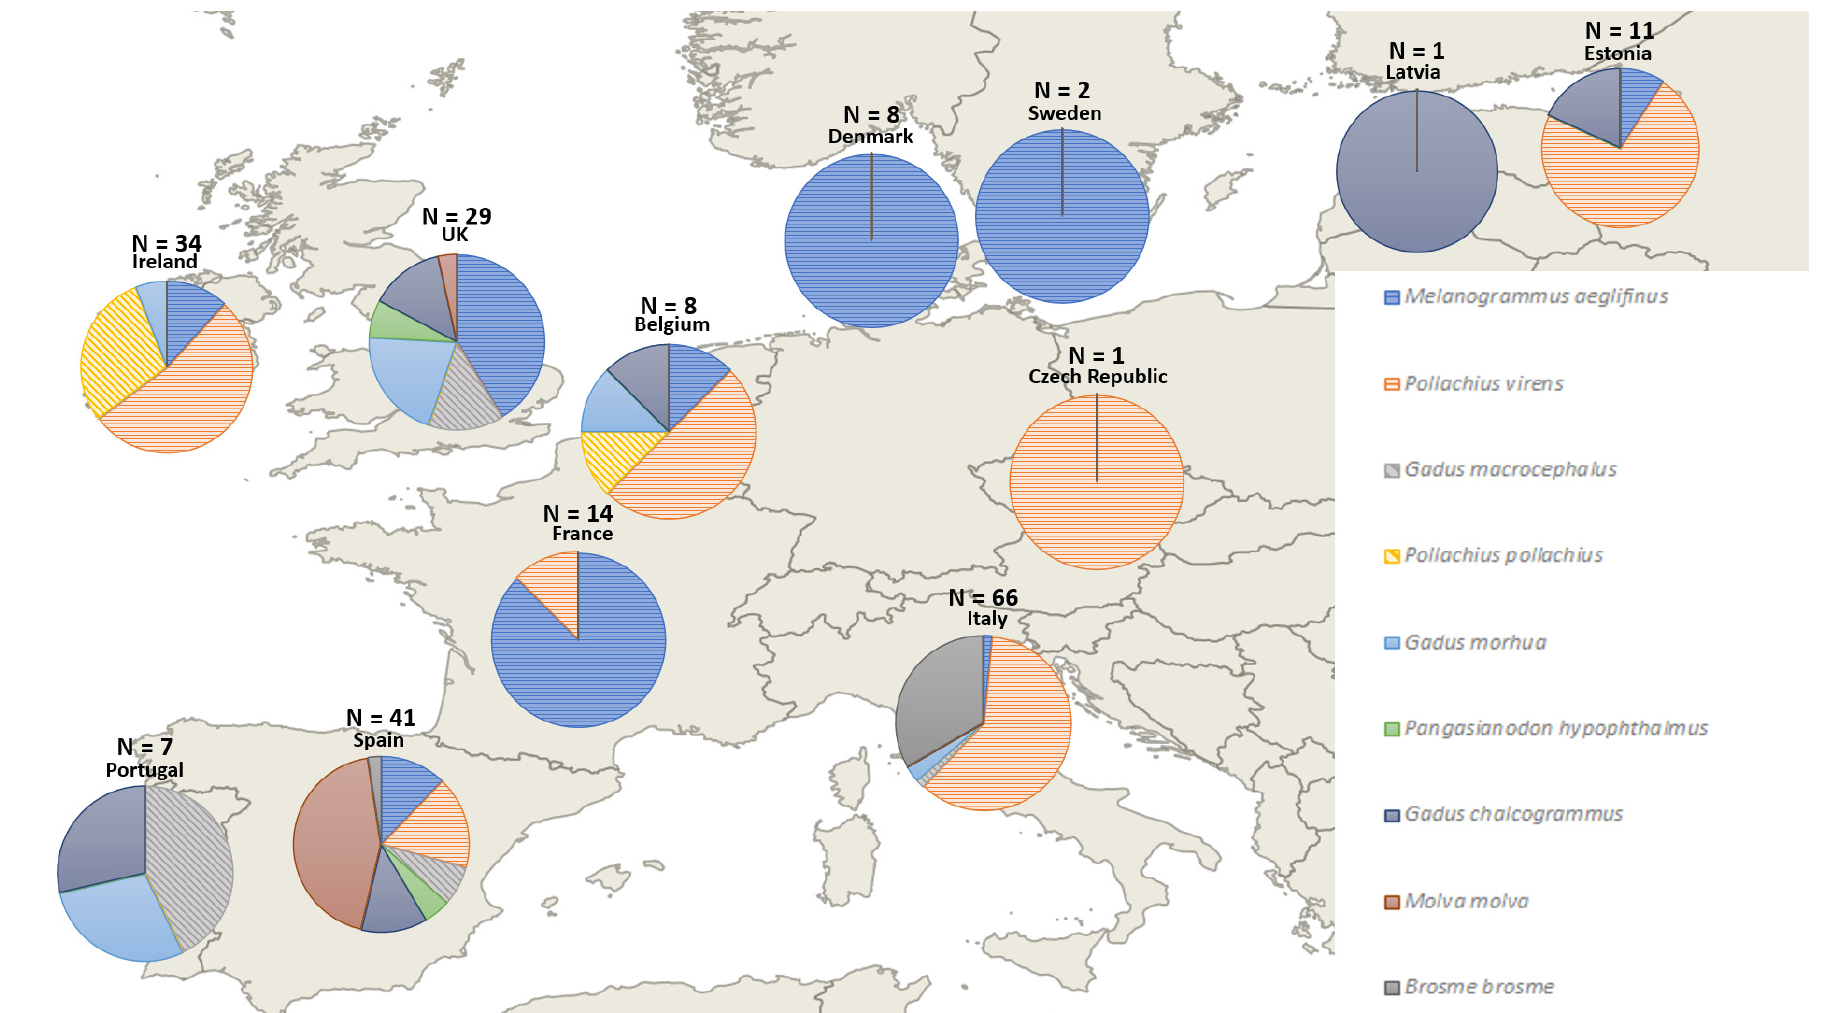
Figure 1. Proportion of substitute species identified in the different countries from cod samples analyzed through DNA barcoding since 2008. Only substitute species occurring in at least 3 different publications or having at least N = 10 were used in this figure.